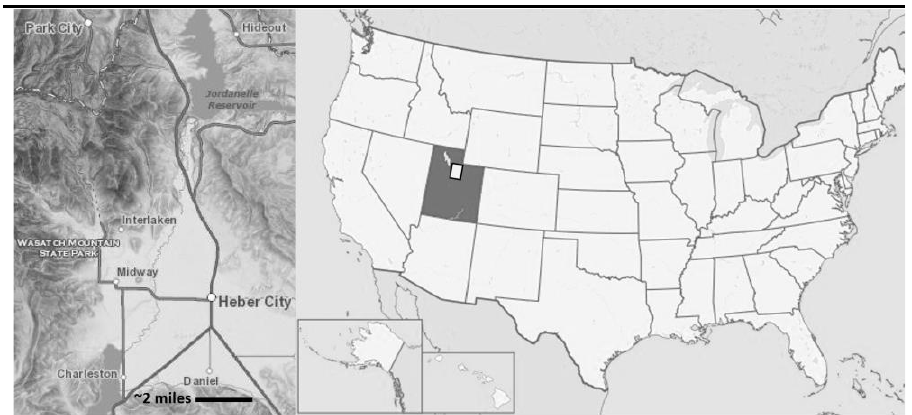
Figure 1. Study Location.